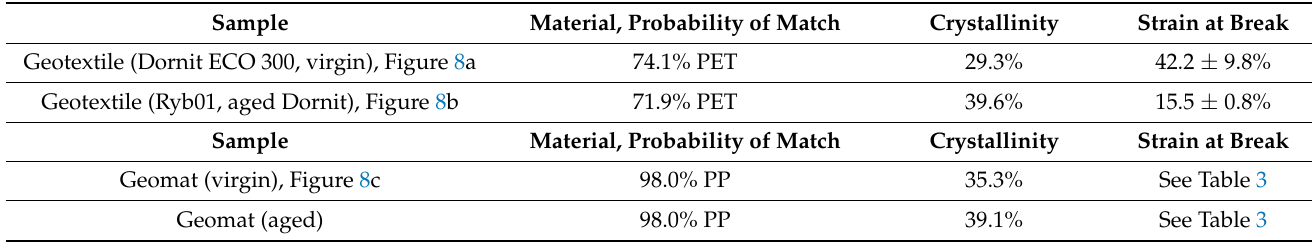
Table 2. Identification of polymers according to IR database (probability of match) and results of the crystallinity analysis of two samples of erosion control geomat and two samples of geotextile.